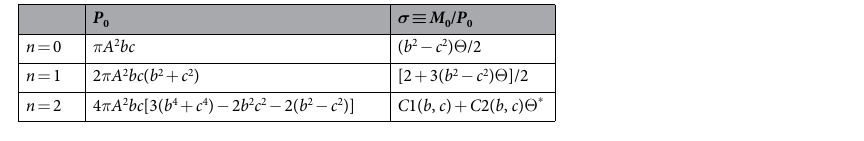
Table 1. Parameters of the spiraling elliptic Hermite-Gaussian beam for different orders of n